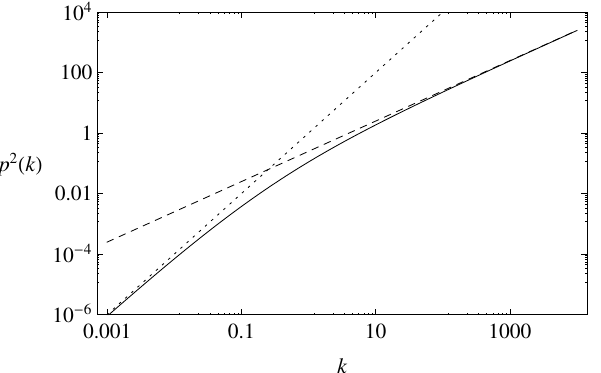
Figure 2 . The binomial distribution (4.19) of the Laplacian eigenvalues (solid curve) corresponding to a bifractal, compared with the ordinary distribution k 2 (usual Laplacian, standard geometry, dotted line) and with the fractional distribution (cid:0)j k j 2 (cid:11) corresponding to a monofractal (dashed line). Here k (cid:3) = 1 and (cid:11) = 1 = 2